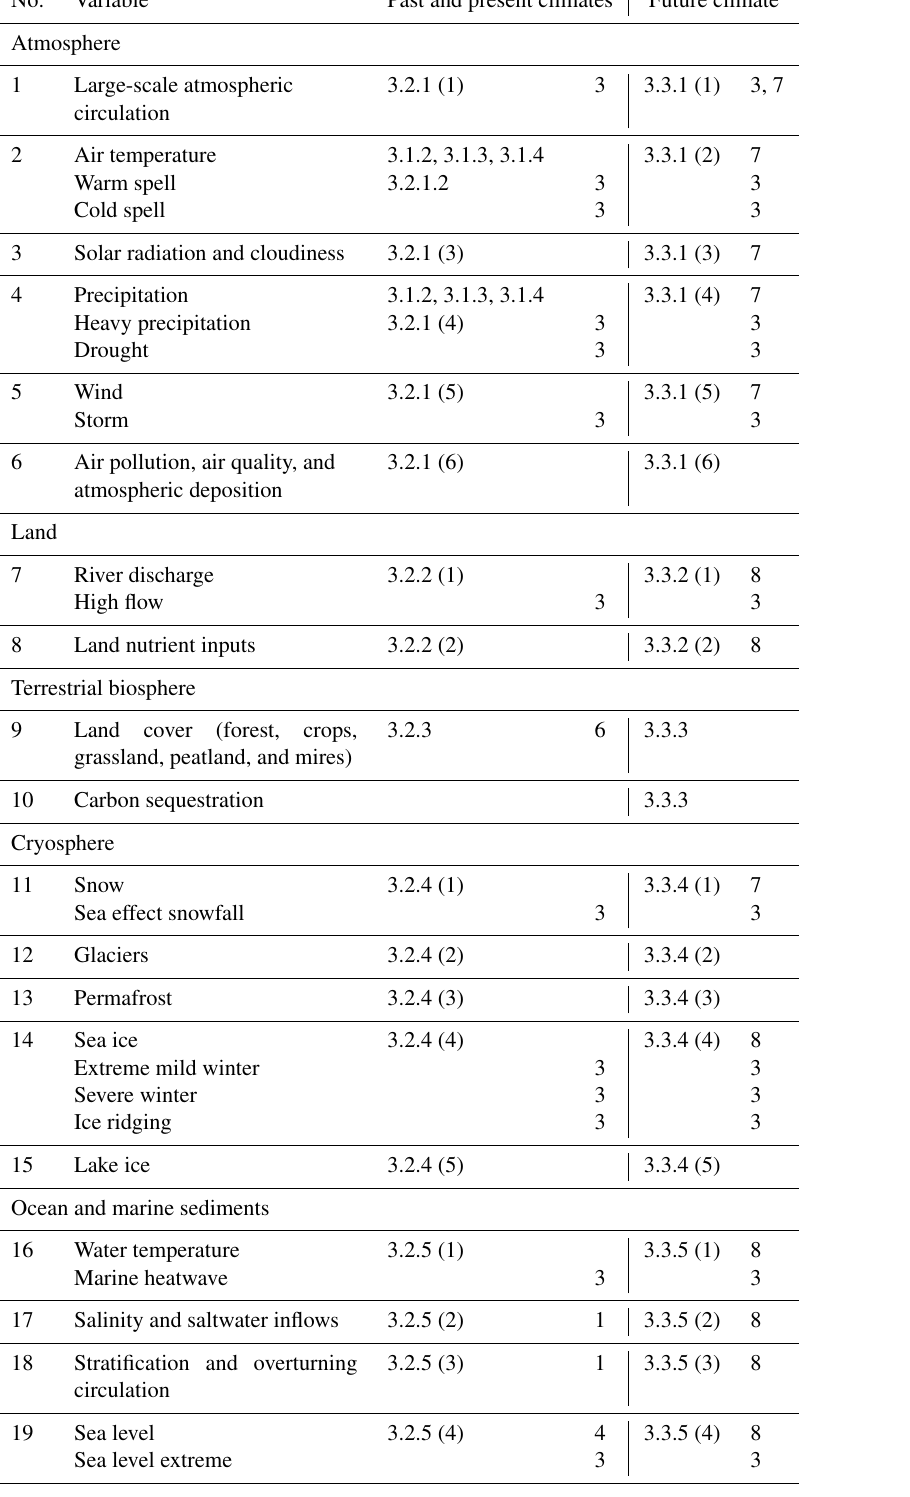
Table 2. Variables of this assessment and references to the corresponding sections of this review and to the corresponding Baltic Earth Assessment Reports (1 – Lehmann et al., 2022; 2 – Kuli´nski et al., 2021; 3 – Rutgersson et al., 2022; 4 – Weisse et al., 2021; 5 –